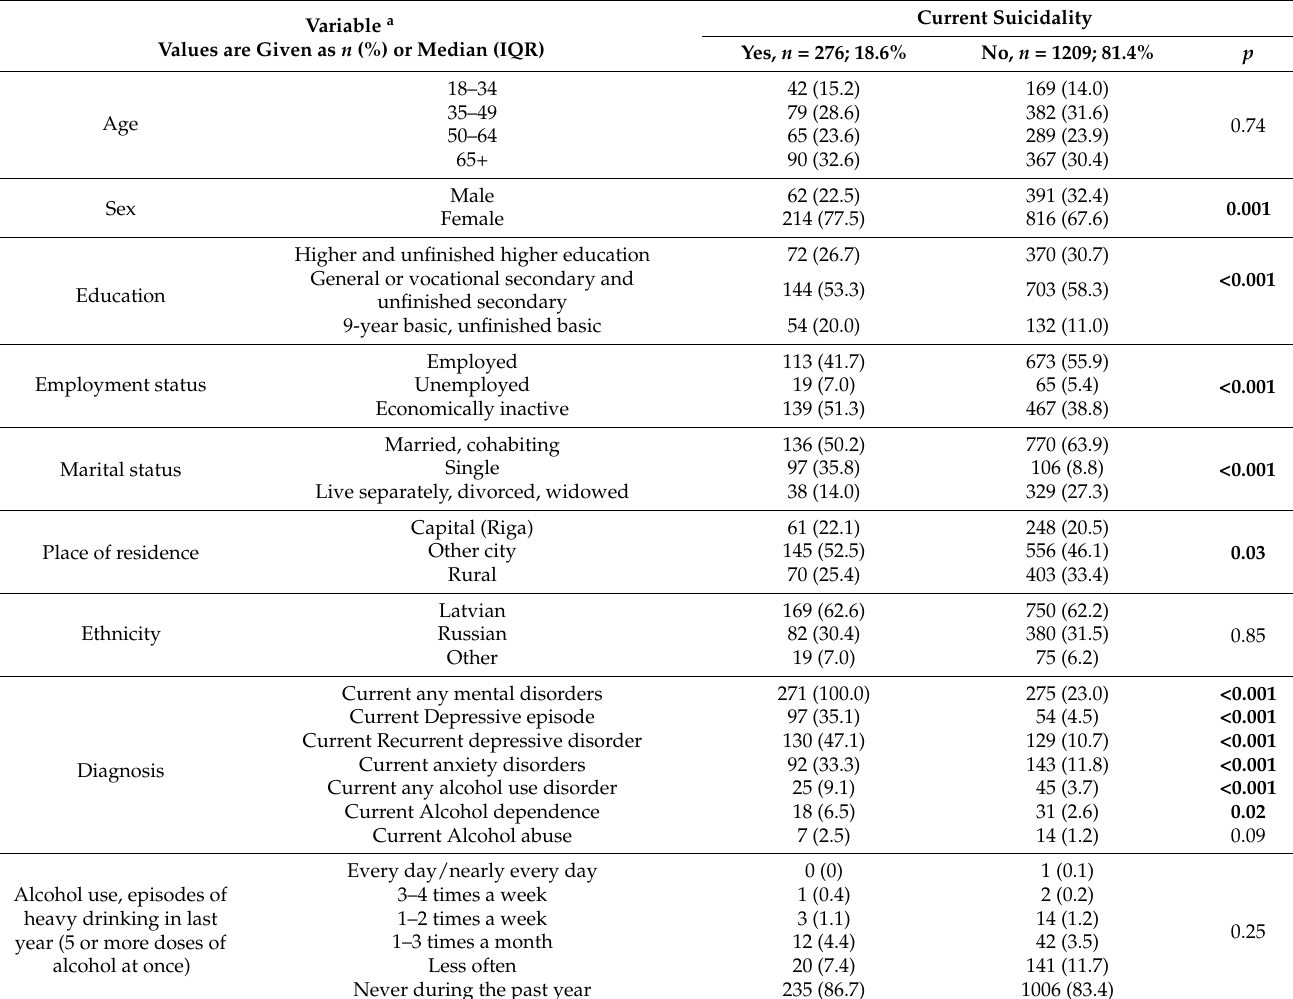
Table 1. Characteristics of study sample ( n =